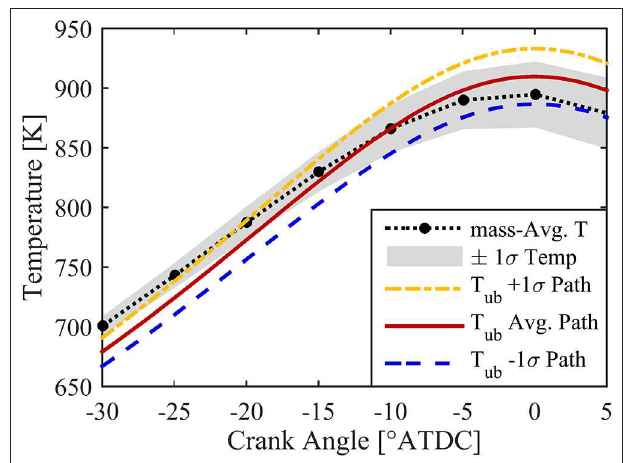
FIGURE 6 | CFD predicted temperature (black) with ± 1 σ region (gray) as a function of crank angle. Also plotted are the polytropic average temperature path (red), + 1 σ path (yellow), and − 1 σ path (blue) as functions of crank